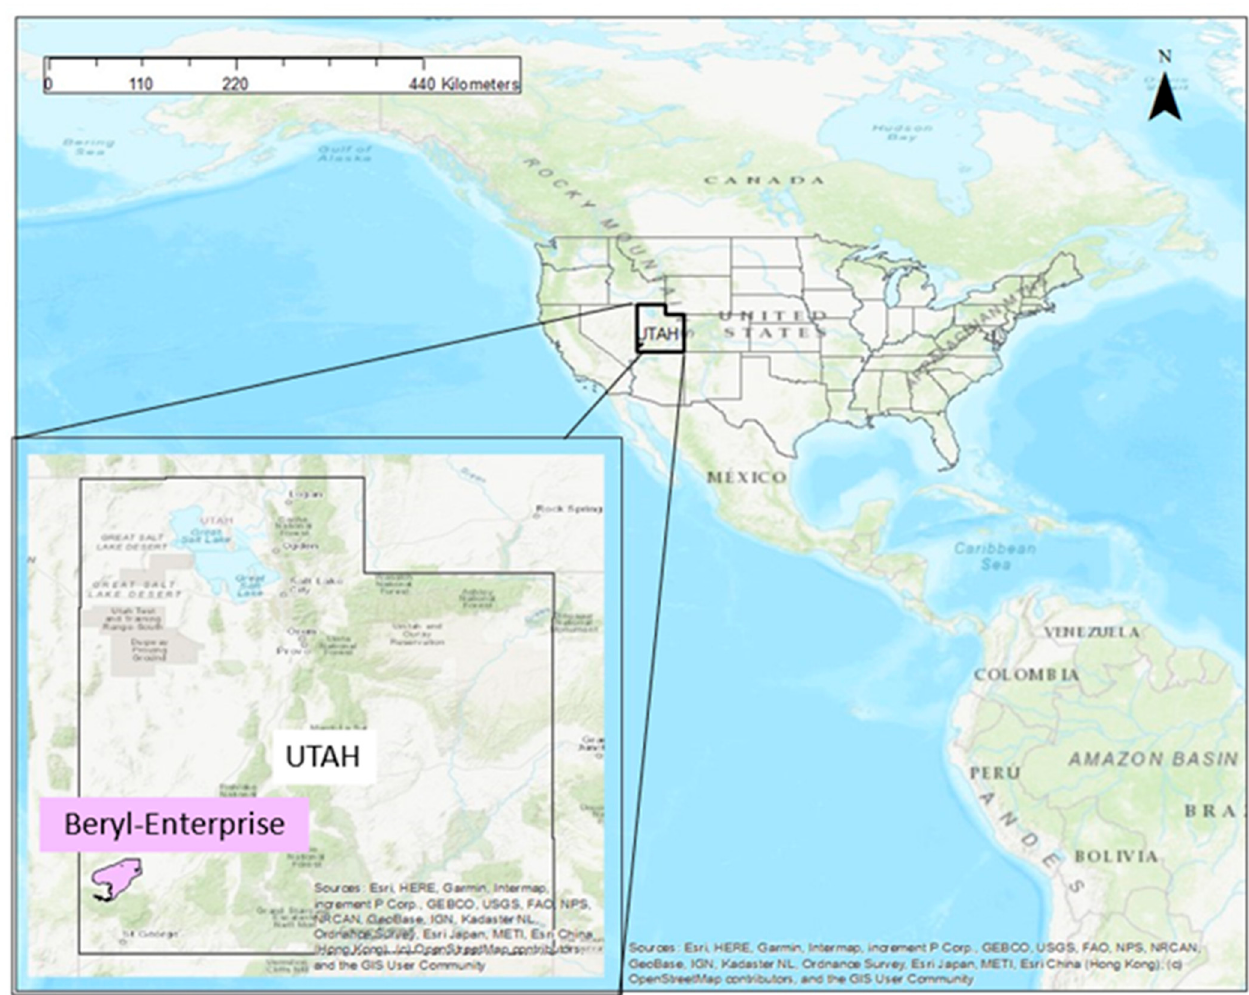
Figure 9. The Beryl-Enterprise aquifer located in the southwest region of Utah, the United